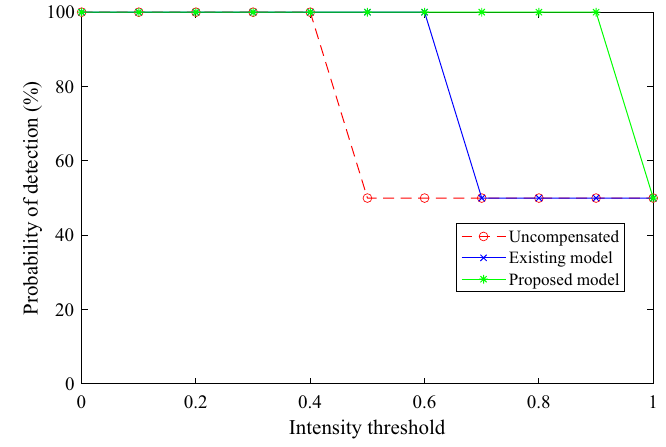
Fig. 5 Probability of detection vs intensity threshold with